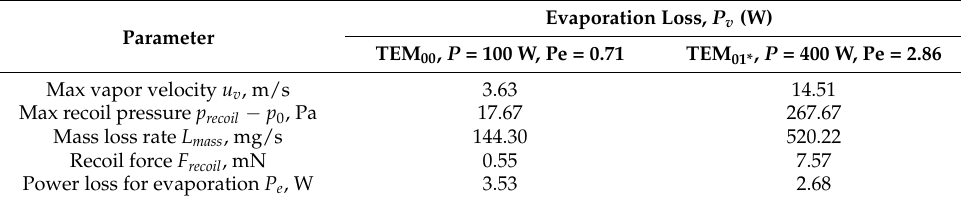
Figure 9. Calculated temperature distributions ( T max – T a ) in CoCr alloy: ( a ) over the vertical plane of mirror symmetry y = 0 formed by the beam axis and the scanning line for P = 100 W, Pe = 0.71; ( b ) over the vertical plane of mirror symmetry y = 0 formed by the beam axis and the scanning line for P = 400 W, Pe = 2.86; ( c ) results of temperature fields modeling for P = 100 W, Pe = 0.71 (cross-section); ( d ) results of temperature field modeling for P = 400 W, Pe = 2.86 (cross-section). Table 7. Calculated values of power loss for evaporation P v for CoCr alloy for the laser beam profiles.